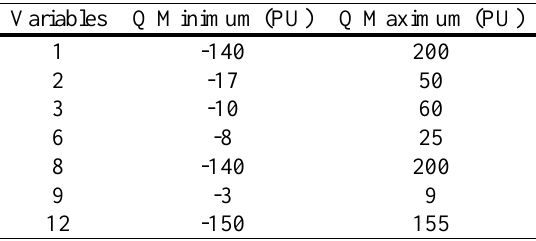
Table 2. Constrains of reactive power generators.